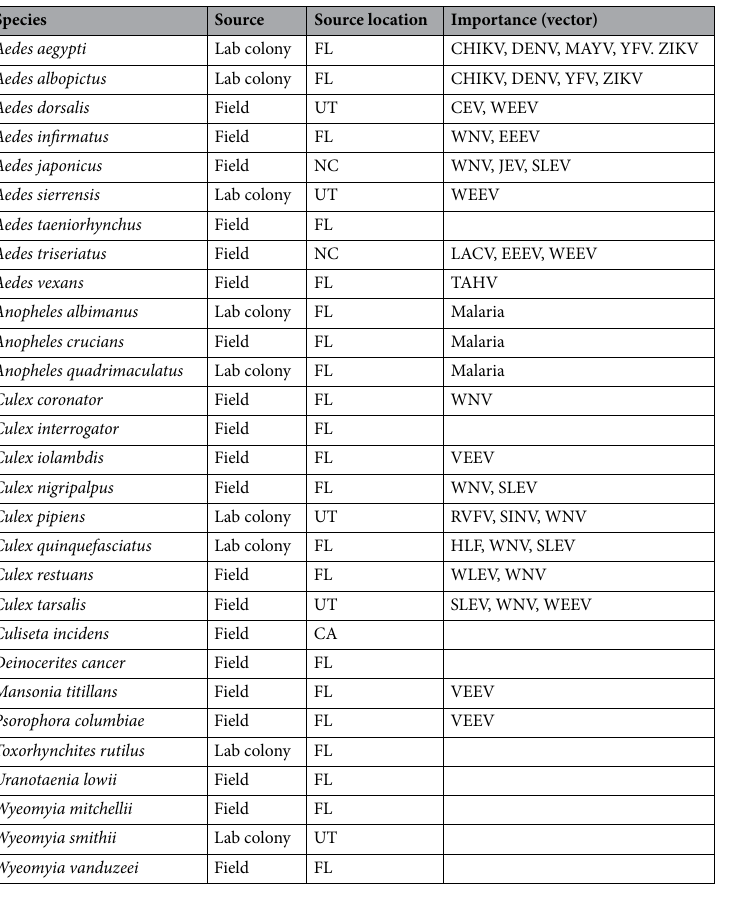
Table 3. Source and medical importance of twenty nine mosquito species used in wingbeat assays. Pathogen associations from Mullen and Durden 2019 47 . California encephalitis virus (CEV), Chikungunya virus (CHIKV), Dengue fever (DENV), Eastern equine encephalitis virus (EEEV), Human lymphatic filariasis (HLF), Japanese B encephalitis virus (JEV), LaCrosse encephalitis virus (LACV), Mayaro virus (MAYV), Rift Valley fever virus (RVFV), Sindbis virus (SINV), St. Louis encephalitis virus (SLEV), Tahyna virus (TAHV), Venezuelan equine encephalitis virus (VEEV), West Nile virus (WNV), Western equine encephalitis virus (WEEV), Yellow fever virus (YFV), Zika virus